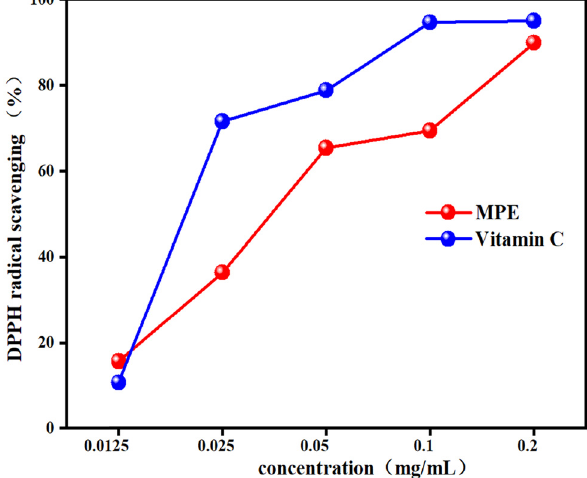
Figure 2: DPPH radical scavenging activity of MPE and vitamin C.